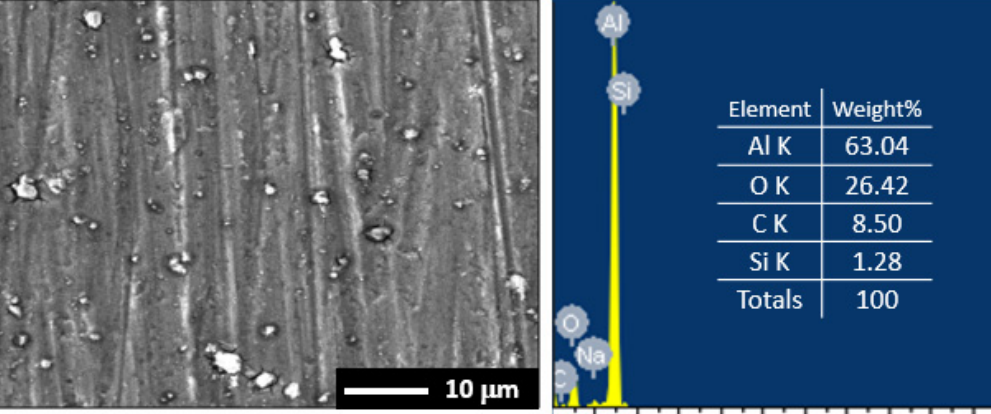
Figure 15. SEM and EDX analyses collected for the third nanocomposite.